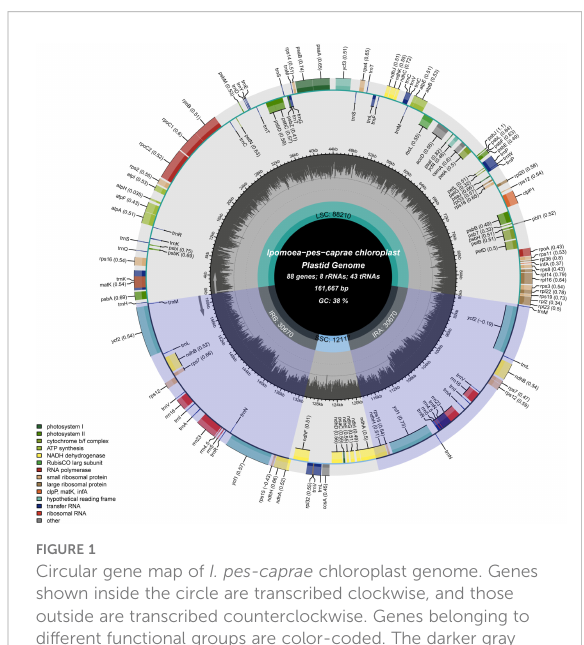
FIGURE 1 Circular gene map of I. pes-caprae chloroplast genome. Genes shown inside the circle are transcribed clockwise, and those outside are transcribed counterclockwise. Genes belonging to different functional groups are color-coded. The darker gray color in the inner circle corresponds to the GC content, and the lighter gray color corresponds to the AT content. LSC, SSC, and IR are large single-copy regions, small single-copy regions, and inverted repeat regions,